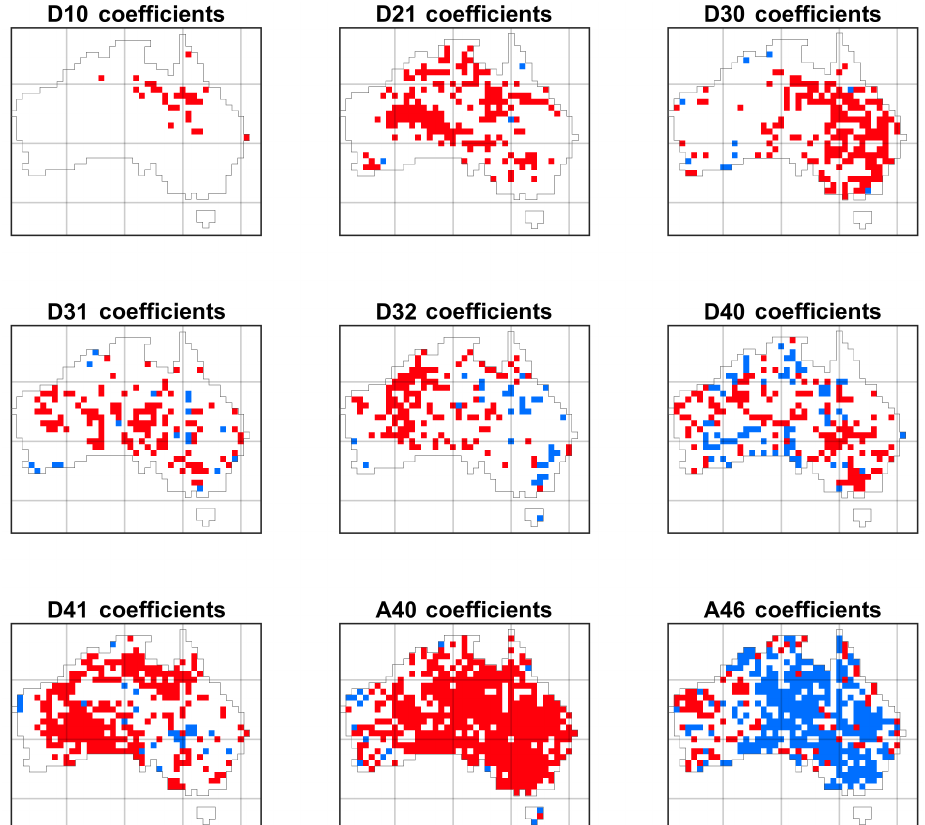
Figure A1. Coefficients for all nine decomposition levels including lags. Red represents a positive coefficient and blue represents a negative